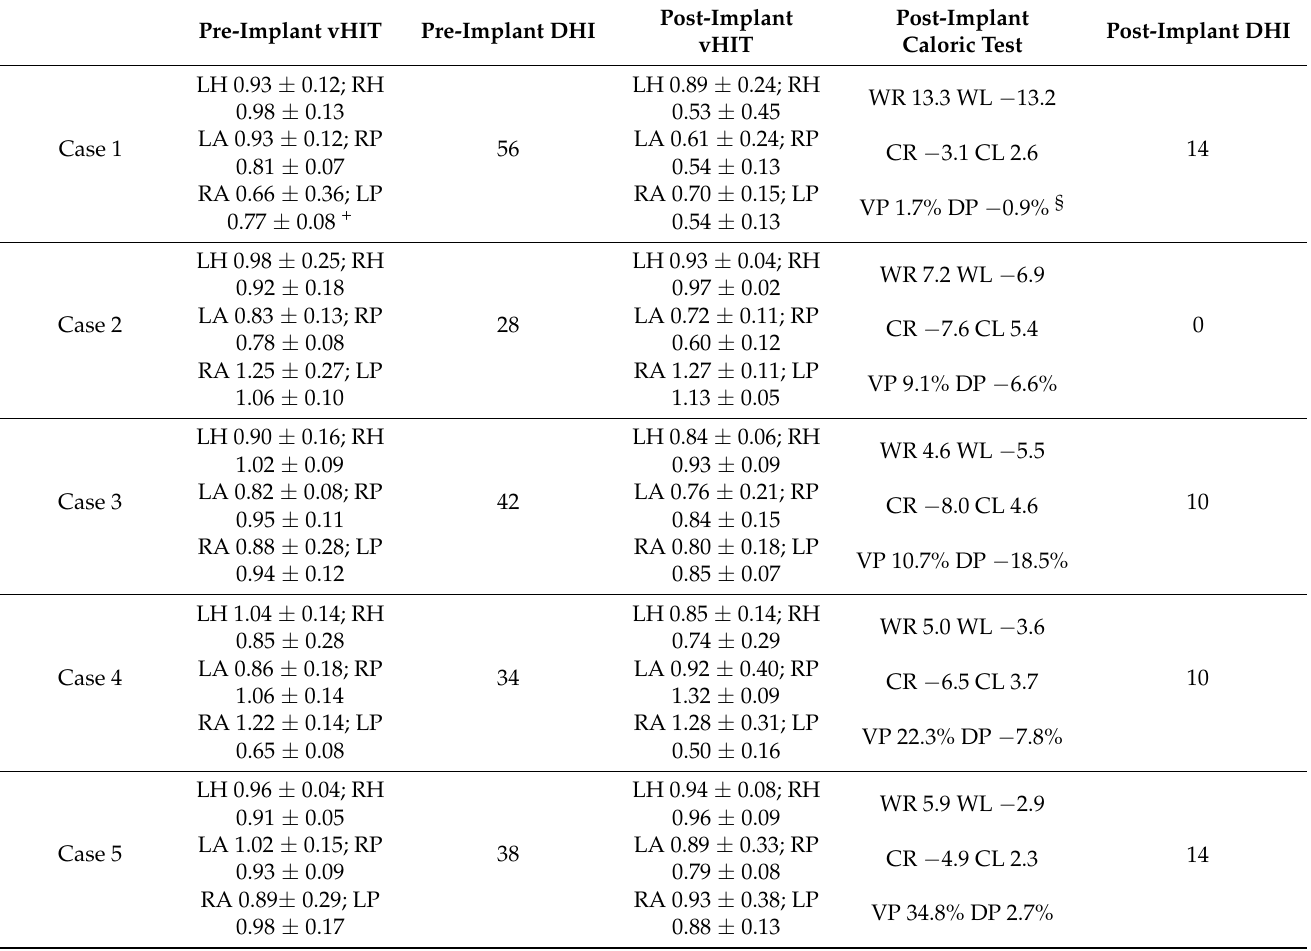
Table 2. Vestibular outcomes before and after cochlear implant placement.